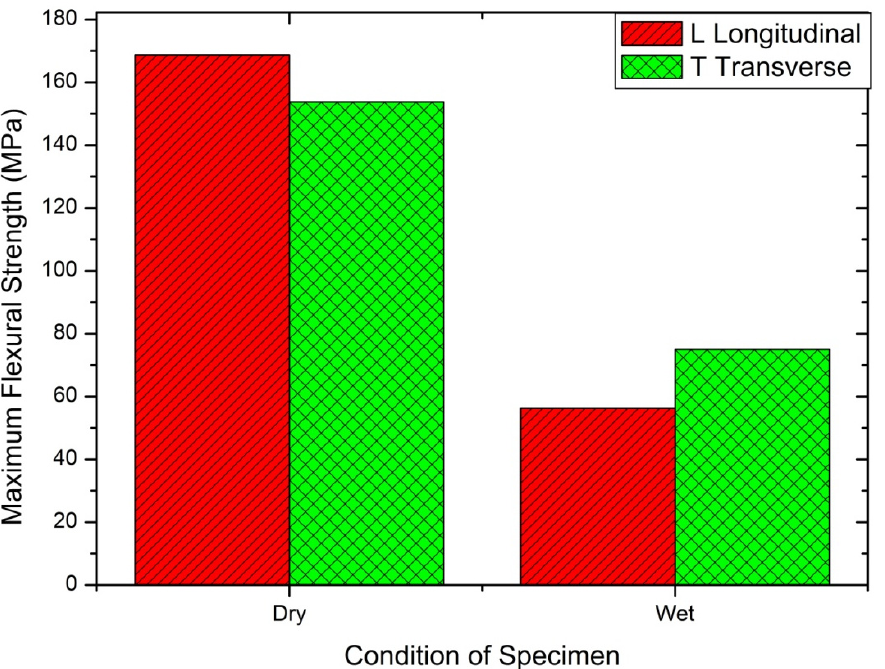
Figure 8. Flexural modulus determined by the three-point method for dry and wet condition in the longitudinal and transverse directions.